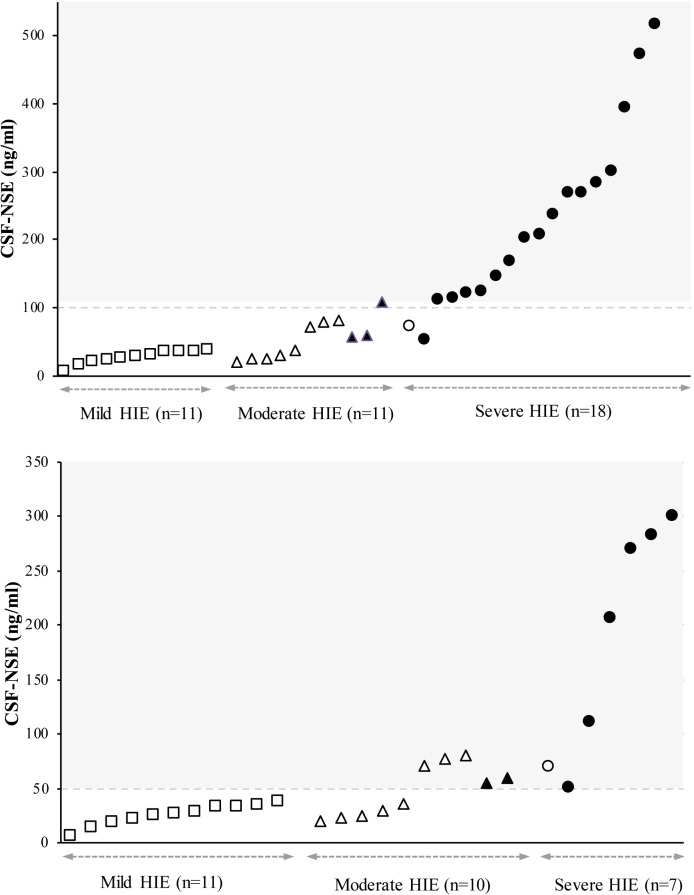
Cerebrospinal fluid levels of neuron-specific enolase of 43 patients according to their neurological findings and outcomes.Each CSF-NSE value represents a square-shaped infant, trigulum, or circle according to the severity of HIE (mild, moderate, or severe). Filled shapes represent infants with adverse ouctomes (death or cerebral palsy and/or BSID-III score < 85). Empty dots represent those infants without adverse outcome. The figure above shows the entire cohort of 43 children, and the one below shows the 29 surviving infants. Two infants with very severe HIE with extreme CSF-NSE values (2855 ng/ml and 1490 ng/ml) and one infant lost in the follow-up are not represented in the figures. The dashed line represents the cutoff value of 108 mg/dL and 50 mg/dl for adverse outcome, according to the maximum predictive accuracy in the receiver operating curve analysis, for the total cohort (figure above) and only the surviving infants (figure below), respectively. HIE: hypoxic-ischaemic encephalopathy; CSF-NSE: cerebrospinal fluid–neuron specific enolase; aEEG: amplitude integrated electroencephalogram; BGP: background pattern; BSID-III: Bayley Scales of Infant and Toddler Development Third Edition; CP: cerebral palsy; MRI: magnetic resonance imaging.